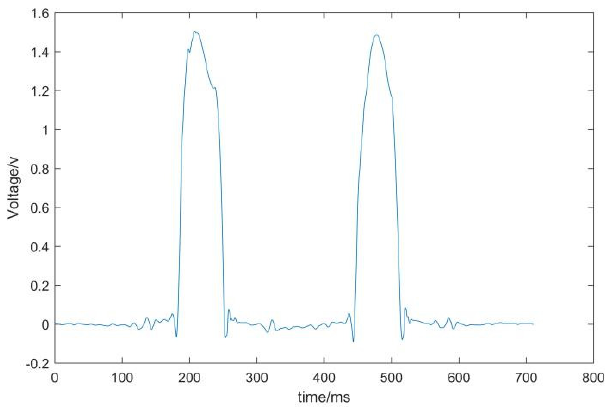
Figure 5. The weighing signal after wavelet transform.